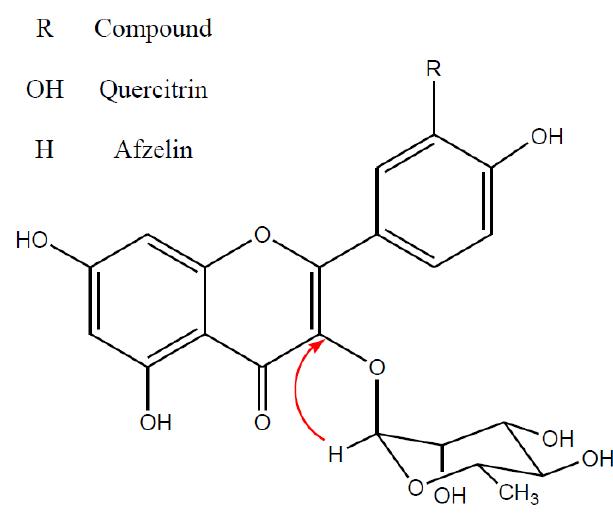
Figure 2. Structures of quercitrin and afzelin isolated from Cornus macrophylla . The arrow is the HMBC of quercitrin and afzelin.